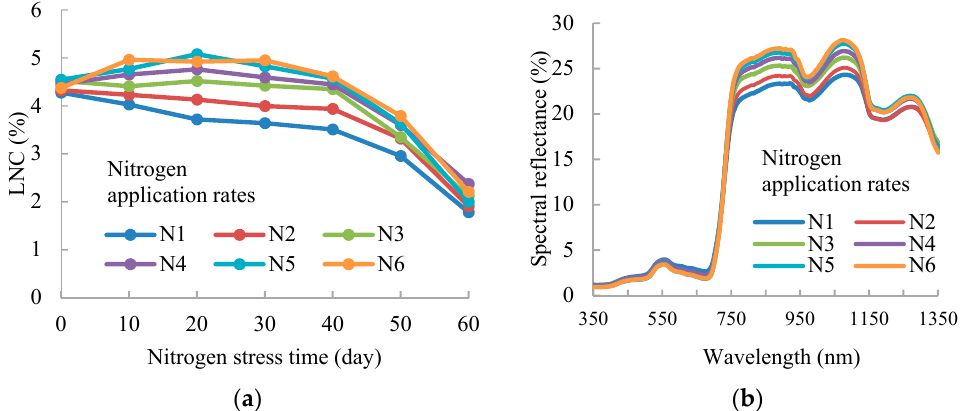
Figure 2. The change of wheat LNC with time in different nitrogen application rates ( a ) and spectral reflectance of wheat canopy with different nitrogen fertilization levels after 30 days of stress experiment ( b ). The six levels of nitrogen stress application were as follows: N1, 0 kg/ha, N2, 75 kg/ha, N3, 150 kg/ha, N4 225 kg/ha, N5, 300 kg/ha, and N6, 375 kg/ha.